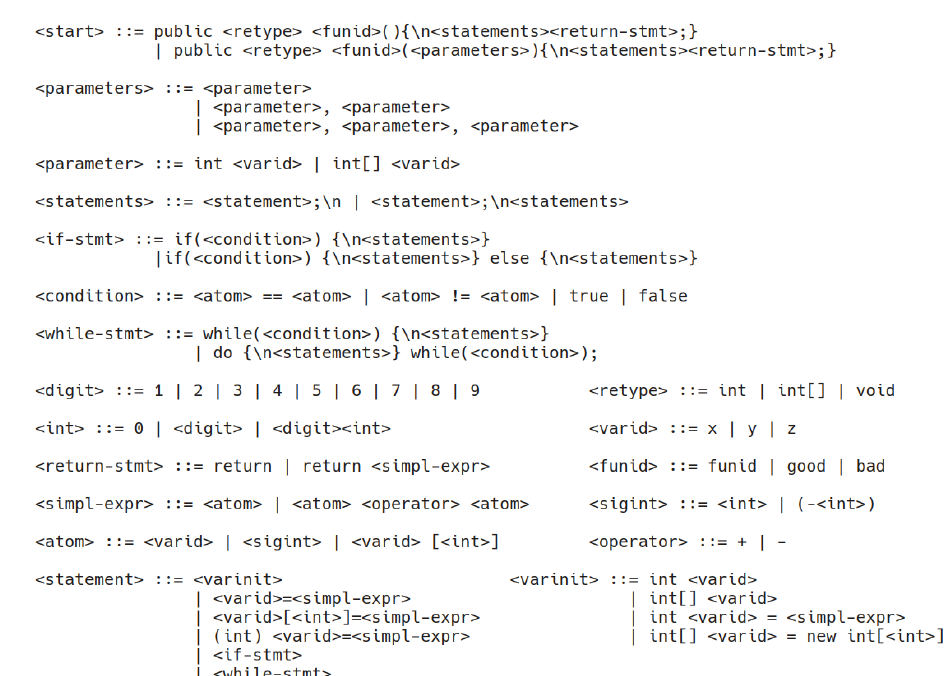
Figure 3. Simplified Java grammar that allows the emergence of the considered possible